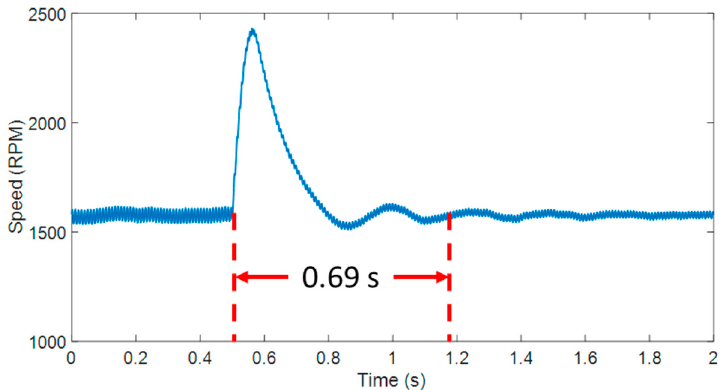
Figure 26. Dynamic response of proposed method.